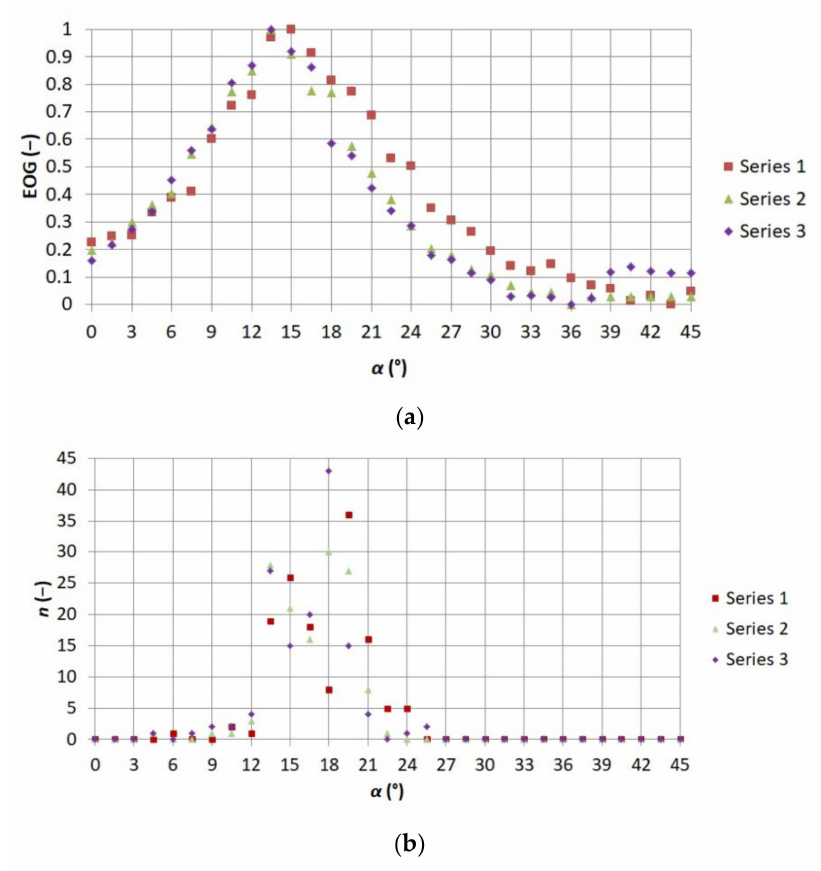
Figure 8. Comparison of relationship ( a ) between EOG measure of sharpness and the angle of focus adjustment ring placed on the thermographic camera lens α 1–3 and ( b ) between numbers of thermograms indicated by observers as sharp n and adjustment ring angle on the thermographic camera lens α